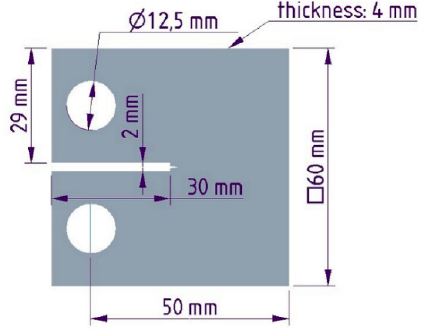
Figure 2. Dimensions of used CT samples.